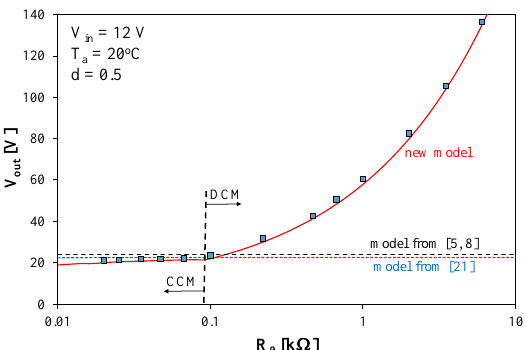
Figure 8. Computed and measured dependences of boost converter output voltage on load resistance.